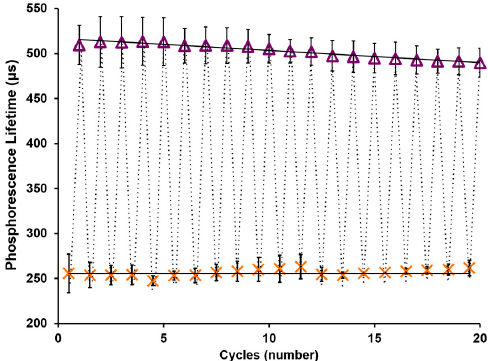
Figure 4. Stability of the AnA hydrogel. Cyclic testing of the AnA hydrogel consisting of crosslinked microparticles tested at interstitial oxygen levels over 2 days. Glucose was varied between 0 mg/dL (orange X) and 400 mg/dL (purple ∆ ). Error bars represent 95% confidence intervals for three separate samples.